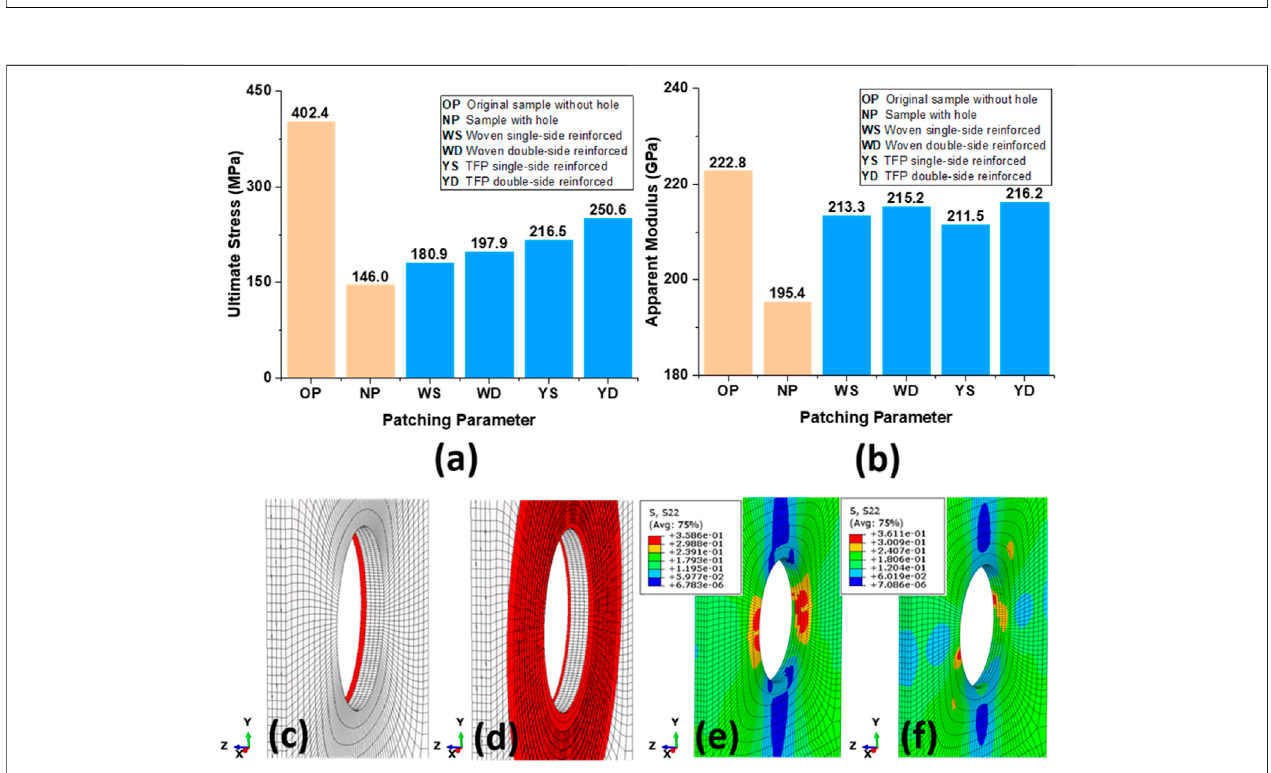
FIGURE 13 | Study on patching parameters: (A) comparison of ultimate stress, (B) comparison of apparent moduli, (C) SSR sample, (D) DSR sample, (E) S22 contour for the SSR sample, and (F) S22 contour for the DSR sample.